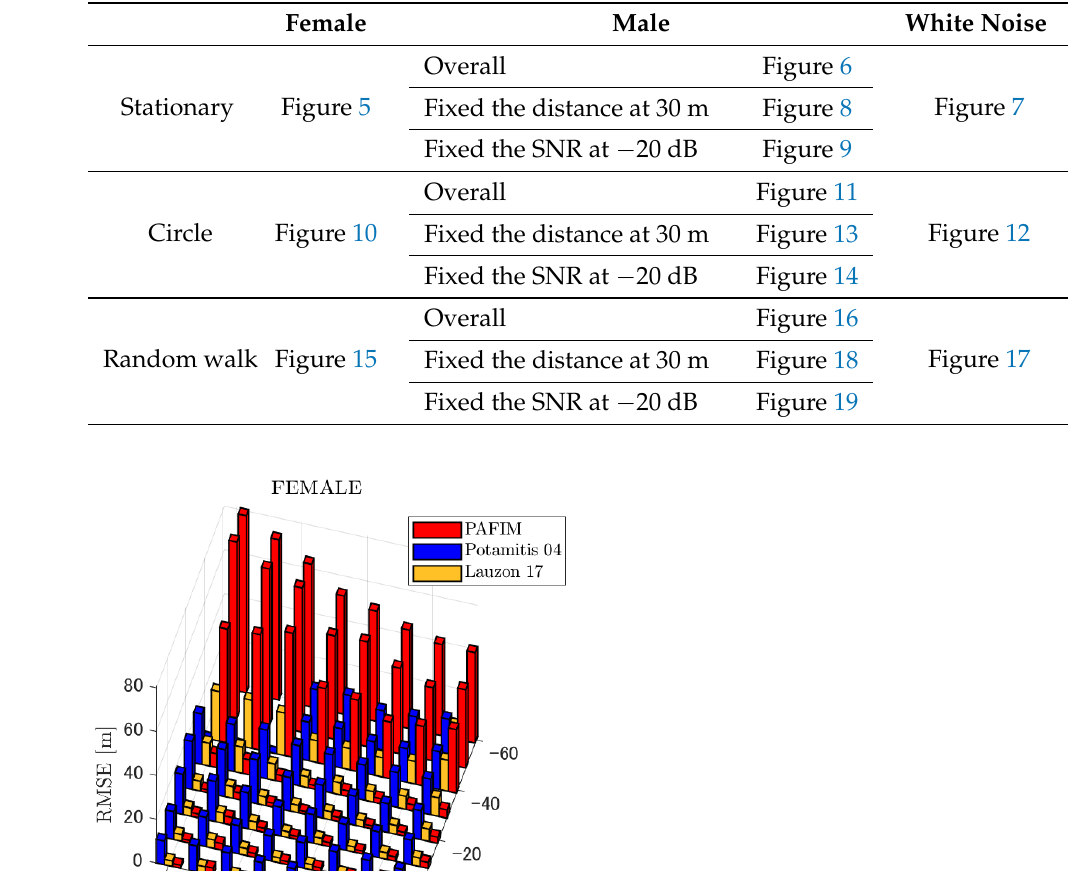
Table 1. Table of figures showing RMSE of simulation results for each source movement and sound type.